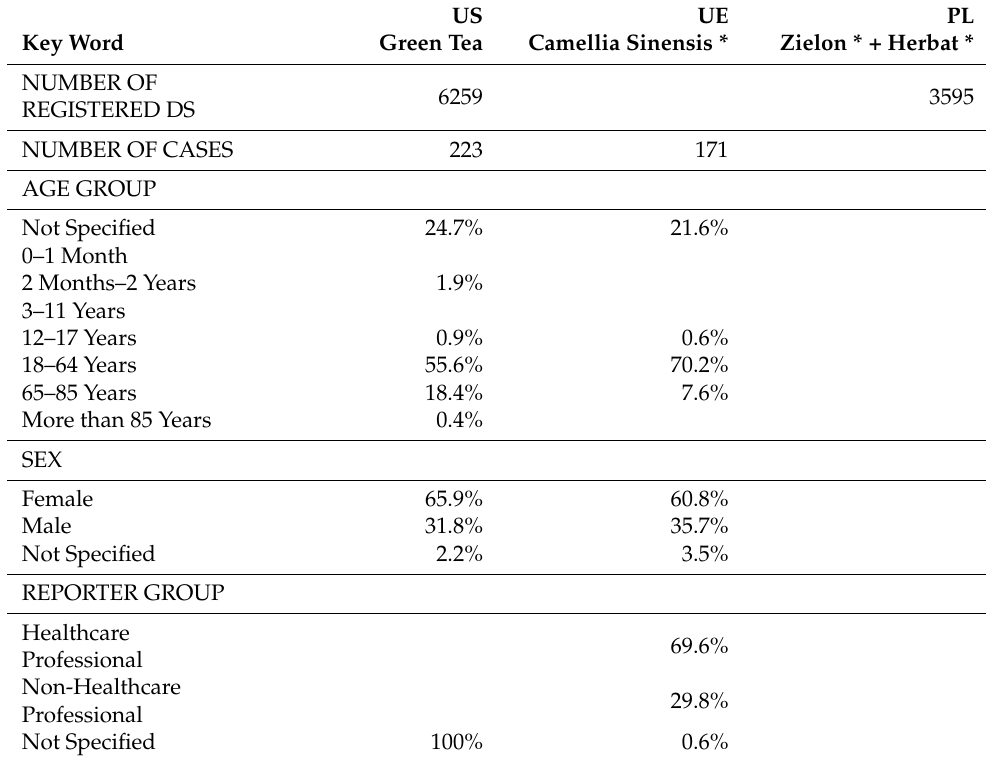
Table 4. Comparison of data on Green Tea from different